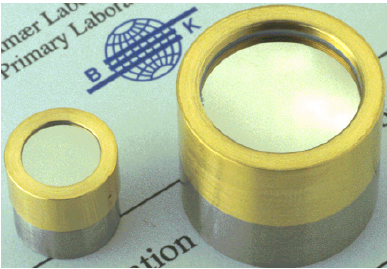
Fig. 2. Laboratory standard microphones. LS2 Ø 12.7 mm (left) and LS1 Ø 23.77 mm (right) may be calibrated by both the pressure and the free-field reciprocity methods and serve as National Reference Standards.